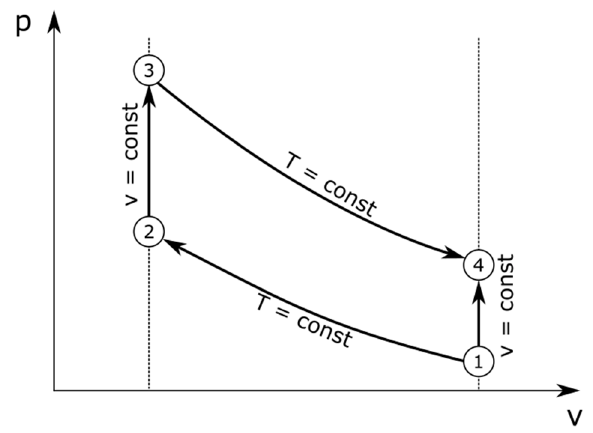
Figure 5. P-V diagram of the Stirling cycle.